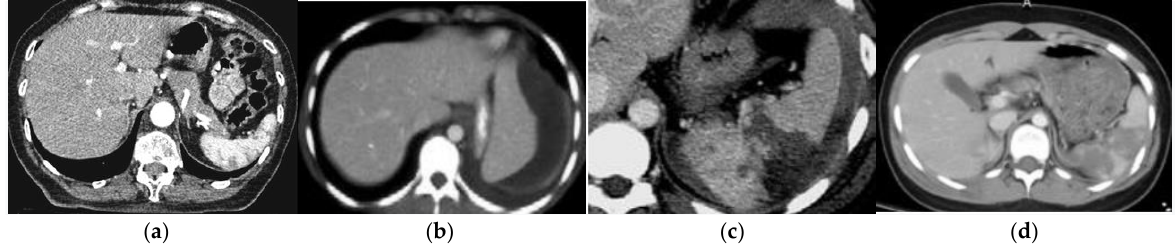
Figure 1. ( a ) Grade I spleen injury, small lacerations as a result of sport injury; ( b ) grade II splenic injury (hematoma) developed after fall from a standing height; ( c ) grade III injury as a consequence of a car accident (splenic lacerations); ( d ) grade IV splenic injury, result of fall from a bicycle.